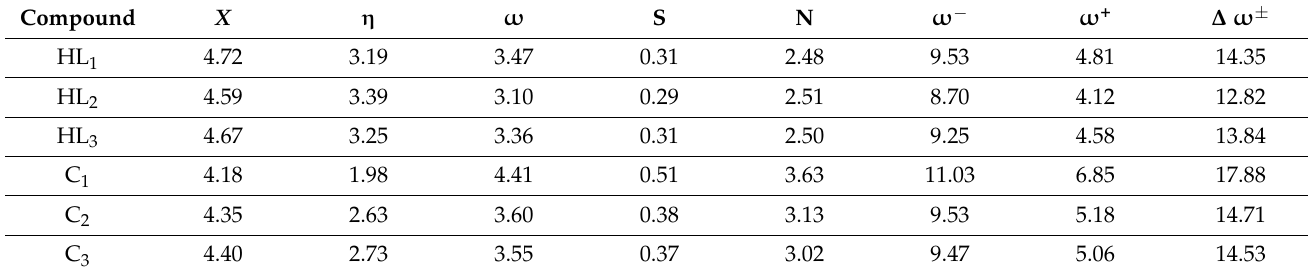
Table 7. Global Reactivity Descriptors of the Ligands and their Ni(II) Complexes.